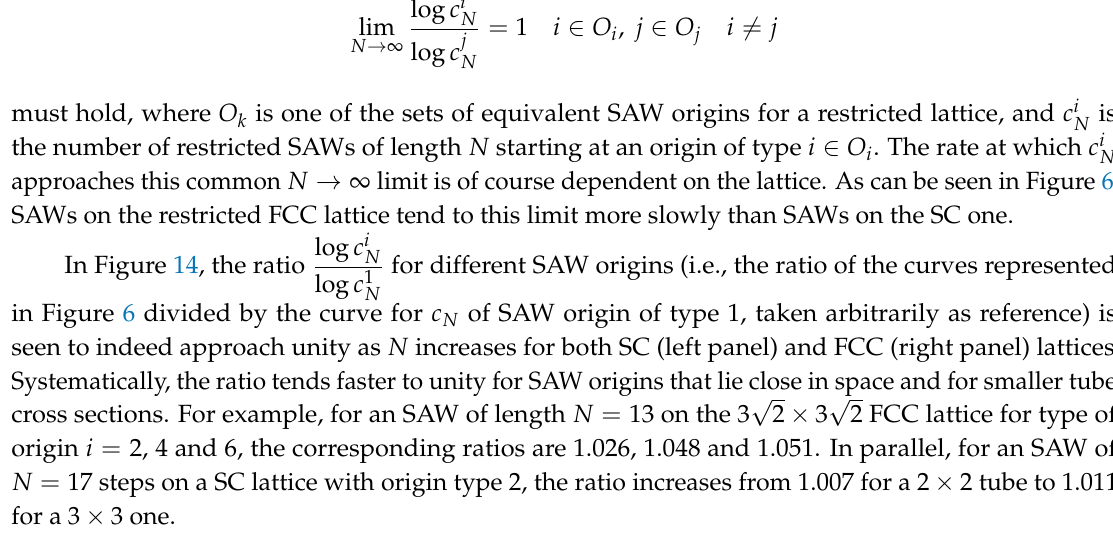
log c i N as a function of SAW steps, N , for different SAW origins i = 2, . . . , | O k | on log c 1 N √ √ 2 × 3 2 (dotted lines) FCC